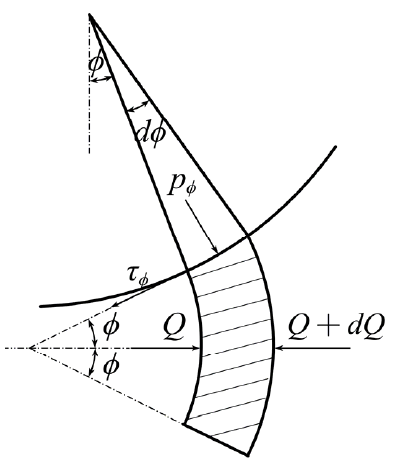
Figure 17. Stress distribution of the force element .